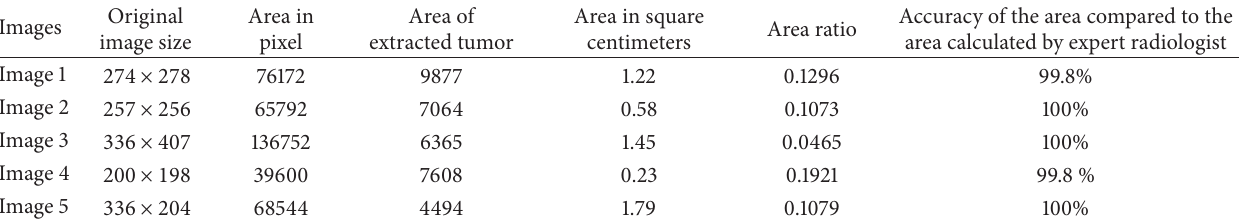
Table 8: Area of the extracted